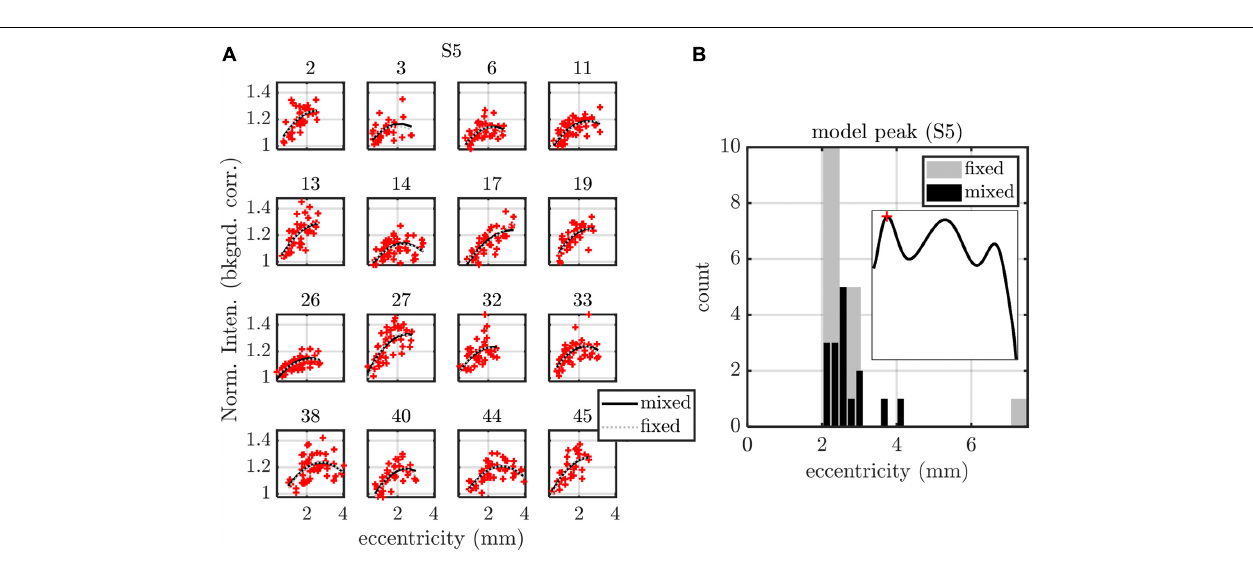
FIGURE 8 | Summary of fixed (fixed intercept, slope, and quadratic term for each subject) and mixed (fixed intercept, slope, and quadratic term as well as random intercept, slope, and quadratic term for each subject) effects models, applied to S5 peak versus eccentricity. (A) Model fits are shown for each of the 16 subjects, with subject index in subplot titles. (B) Both fixed and mixed effects models predict a maximum of the parabolic S5 peak profile around 2.4 mm eccentricity. Models for all other stratification parameters are summarized in Table 1 (eccentricity as a predictor) and Table 2 (IPL thickness as a